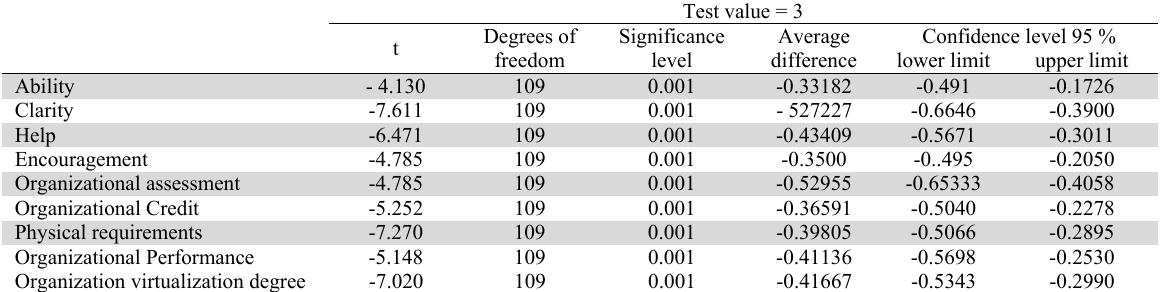
Single-sample t test results t in comparison of the average of each of the research variables and the average